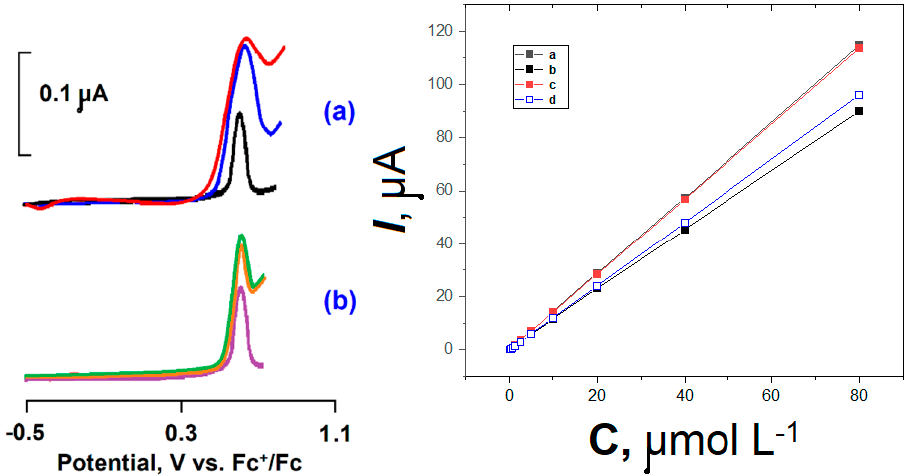
Figure 9. DPV voltammograms ( on the left ) of the Co II @SiO 2 oxidation at CPE without and in the presence of increasing amounts of of phosphorus compounds (at the first addition of OPC). ( a ): w/o